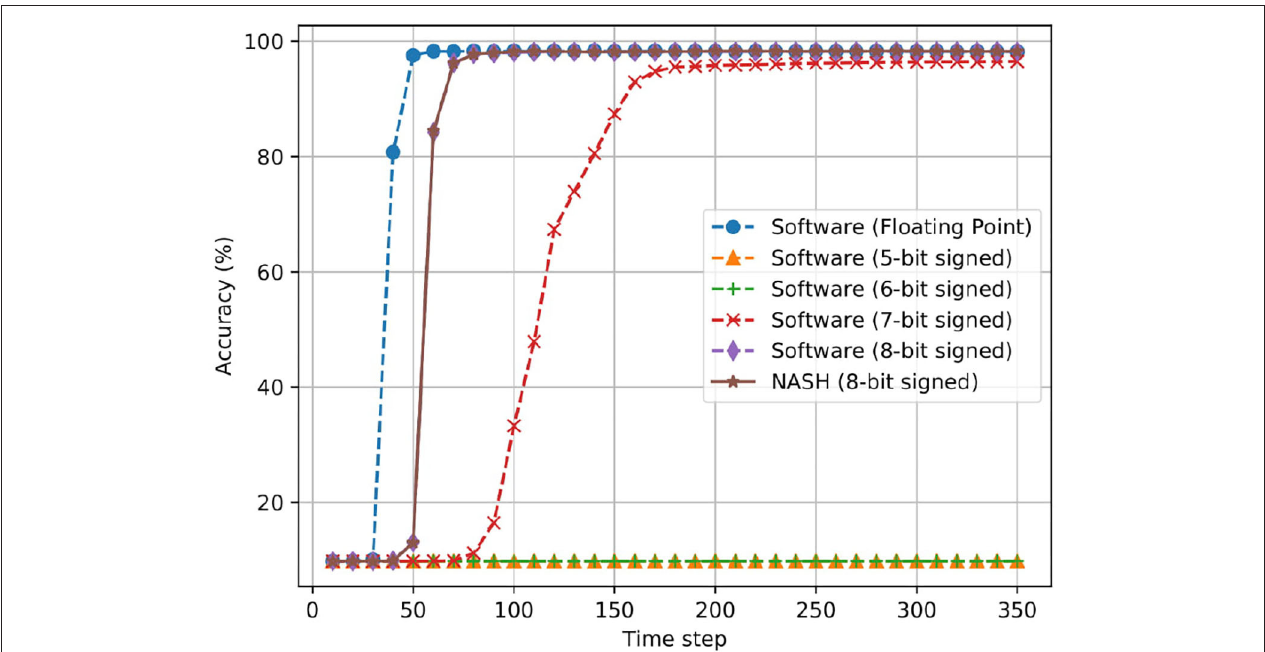
FIGURE 17 | Accuracy result of offline training for MNIST dataset with the network model 784:1024:1024:10.